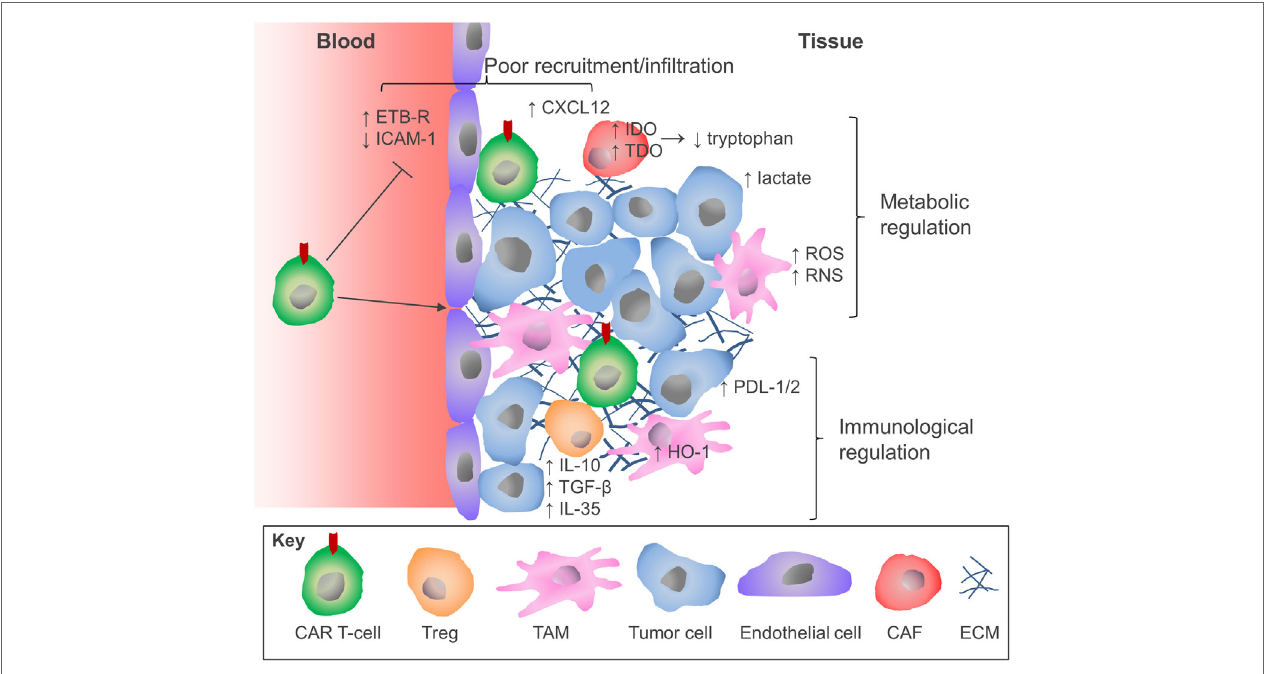
FigURe 2 | Overview of the barriers to CAR T-cells in solid